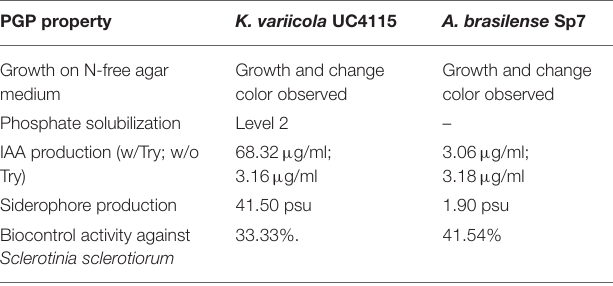
TABLE 1 | Plant growth promotion properties of K. variicola UC4115 and A. brasilense Sp7. PGP property